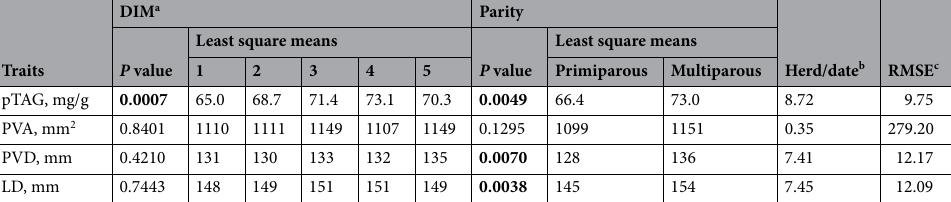
Table 1. Results from linear mixed model ( P values) and least square means for predicted liver triacylglycerol (pTAG), portal vein area (PVA), portal vein depth (PVD) and liver depth (LD). P values < 0.1 are highlighted using bold. a DIM classes are: class 1 ≤ 30; 30 < class 2 ≤ 60; 60 < class 3 ≤ 90; 90 < class 4 ≤ 120; class 5 > 120. b Variability explained by the random factor herd/date is expressed as a percentage. c RMSE root mean square